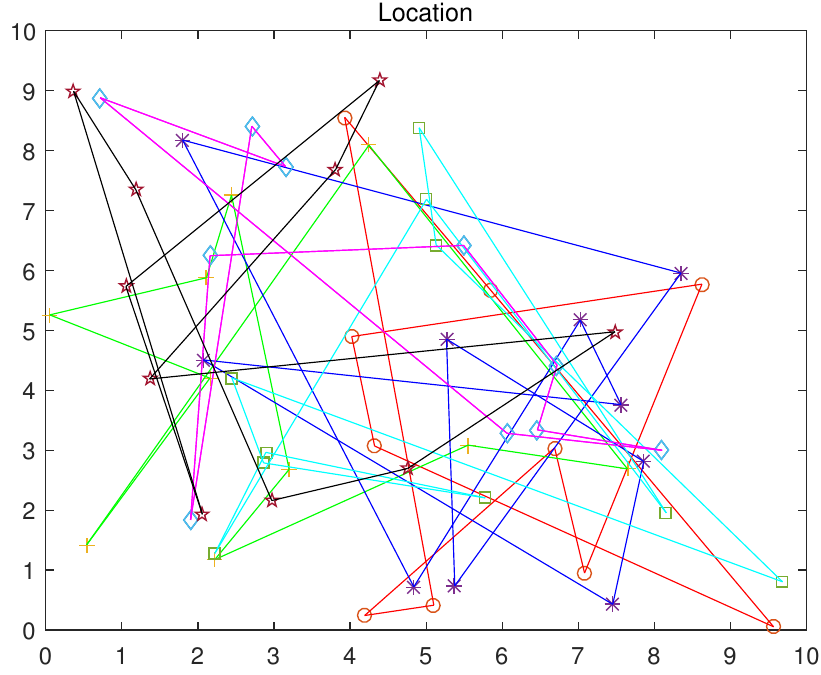
Figure 4. Route of multiple agricultural machine rental.